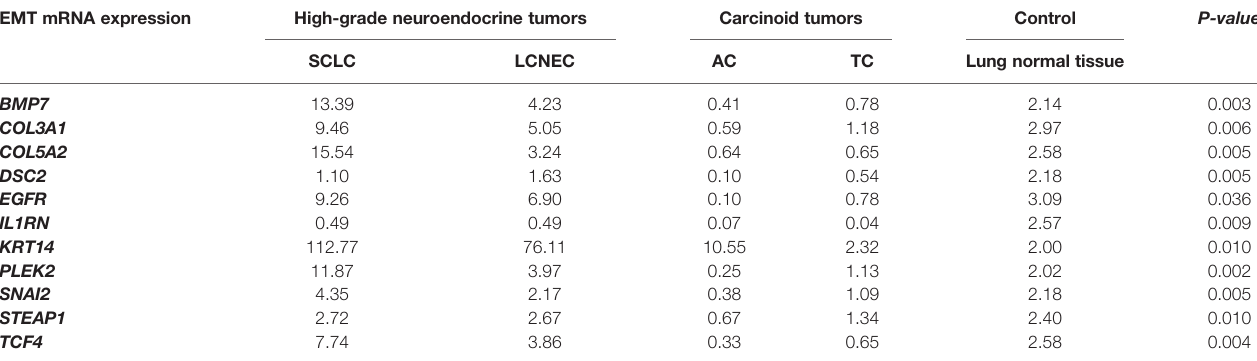
TABLE 1 | Association between median EMT gene expression and histological subtypes of PNENs patients by non-parametric Kruskal-Wallis test, (P<0.05). EMT mRNA expression